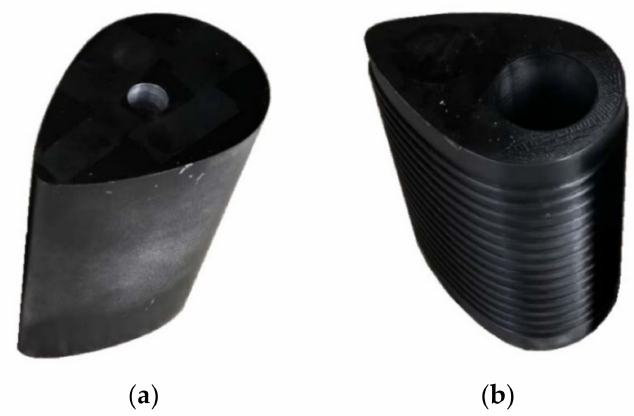
Figure 8. Scale models used in the tests: ( a ) without rings; ( b ) with rings. The tests were conducted in a 0.55 m × 0.4 m wind tunnel, see Figure 9. In the tests, the velocity of the airflow was 60 m/s, and the flow field was measured using high-frequency particle image velocimetry (PIV). The PIV camera is FASTCAM SA-Z, of which the single exposure frequency is 2 kHz and the lens magnification is 3.427 pixel/mm (the corresponding field of view resolution is 0.3 mm). The laser is an Nd:YLF with a single-cavity frequency of 1 kHz. The tracer particles are glycerin with a diameter of 1 µ m, which has very good followability at a wind speed of 60 m/s. The software used for camera data processing is PIVtect Pivviewer2C, and the query window of the camera is 32 pixels × 32 pixels.